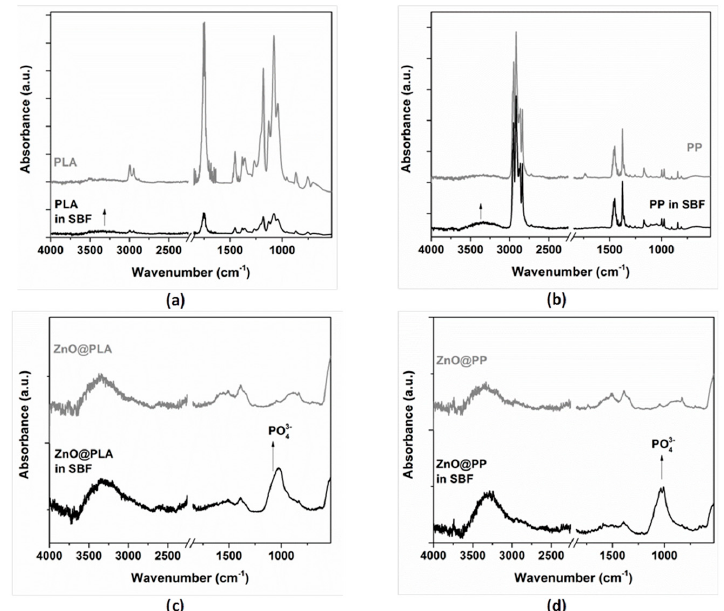
Figure 11. ATR-IR spectra of the samples after soaking in SBF for 14 days: ( a ) only PLA; ( b ) only PP; ( c ) ZnO@PLA; ( d ) ZnO@PP.